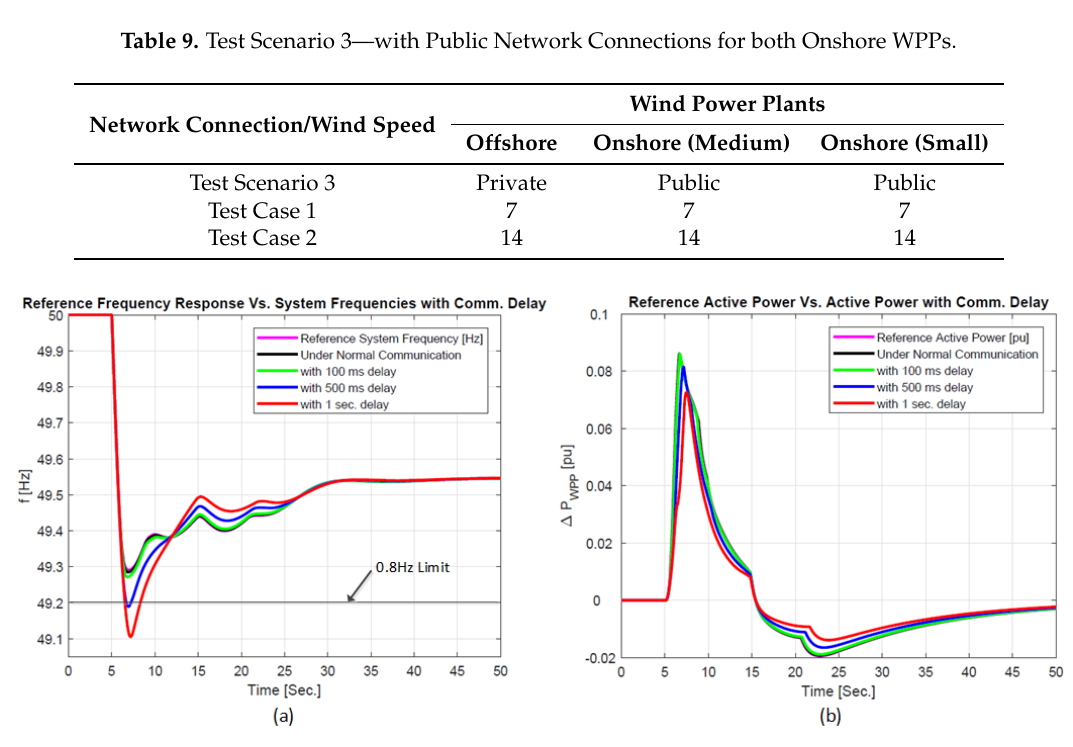
Figure 15. Figure showing at Partial Load ( a ) System Frequency Response and ( b ) Total Active Power under different delay conditions compared to the Reference Frequency Response and Reference Active Power, respectively.